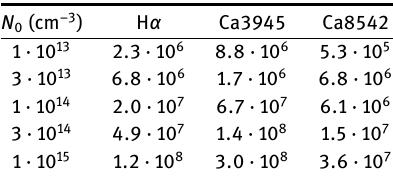
Table 3. Fluxes in the hydrogen and calcium lines in the shock wave model for the velocity V = 40 km/s.